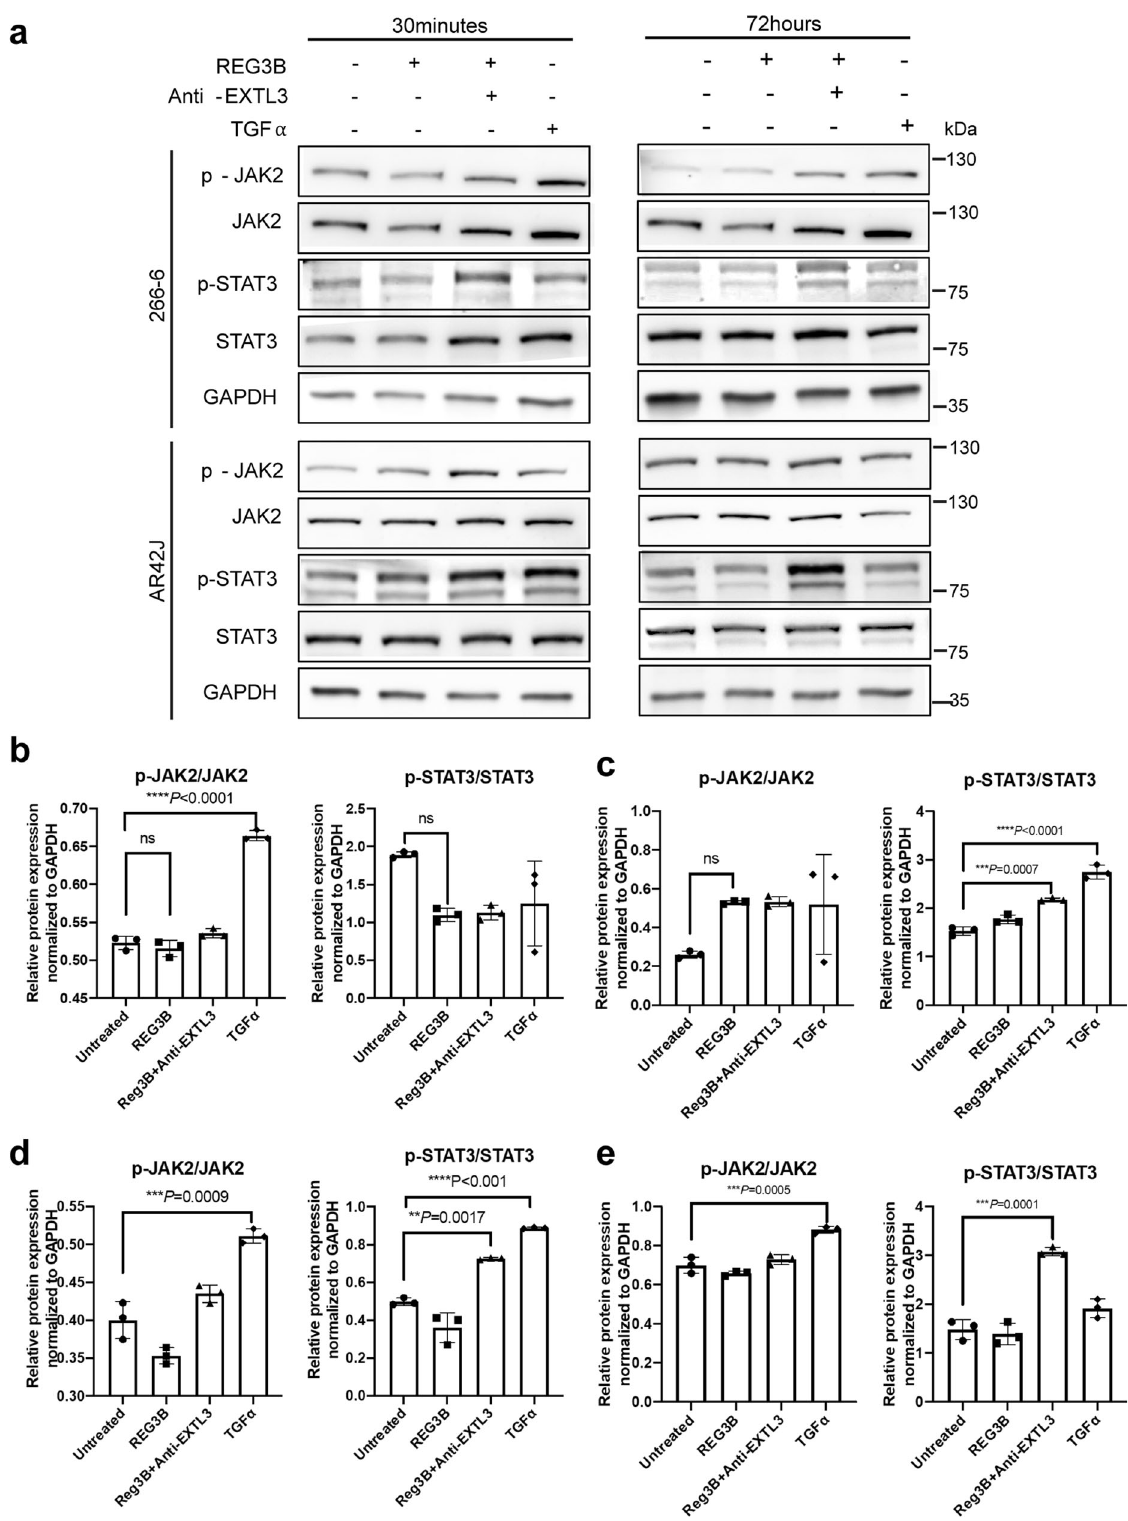
Fig. 7 JAK2/STAT3 is not involved in REG3B-induced ADM. a Western blot analysis of related protein expression in 266-6 and AR42J cell lines 30 min and 72 h after different stimulations, with quanti fi cation data. b , c Expression level of JAK2/STAT3 signaling components in the 266-6 cell line under different conditions for 30 min ( b ) and 72 h ( c ). d , e Expression level of JAK2/STAT3 signaling components in the AR42J cell line under different conditions for 30 min ( d ) and 72 h ( e ) ( n = 3, one-way ANOVA test). REG3B treatment alone did not increase p-JAK nor p-STAT3 expression at two timepoints in two cell lines but did increase their expression once the receptor EXTL3 was